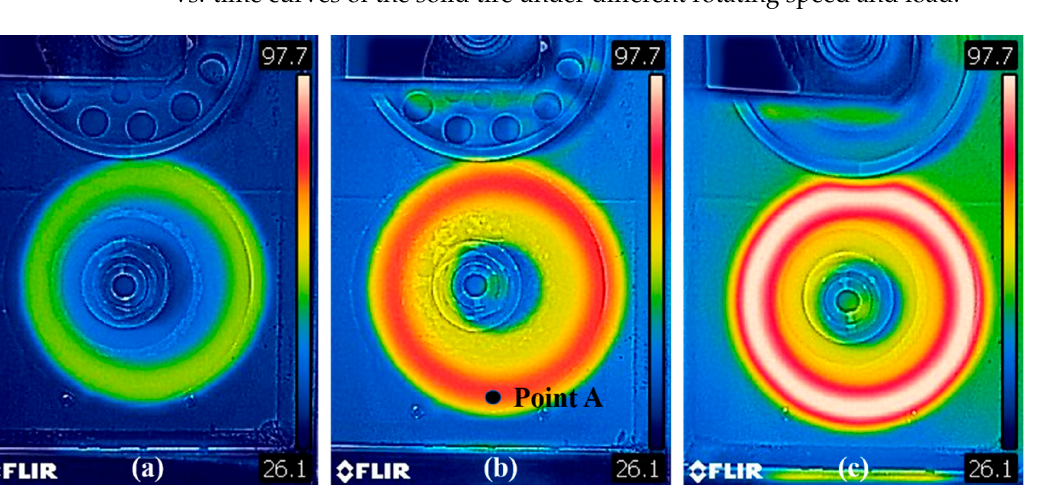
Figure 15. ( a ) Test data of the temperature vs. time curves at Point A shown in Figure 14b under different rotating speed and load, and ( b ) test data of the RR vs. time curves under different rotating speed and load. 5.2. HBU and RR Simulation Results of the Three Solid Tire Finite Element Models at Different Loading Conditions 5.2.1. Lagrangian–Eulerian Finite Element Model of the Solid Tire Contour plots of steady-state surface temperature of the Lagrangian–Eulerian tire model under three different rolling conditions are shown in Figure 16. Table 3 presents the numerical results of the RR and maximum steady-state surface temperature of the Lagrangian–Eulerian solid tire model under three rolling conditions.